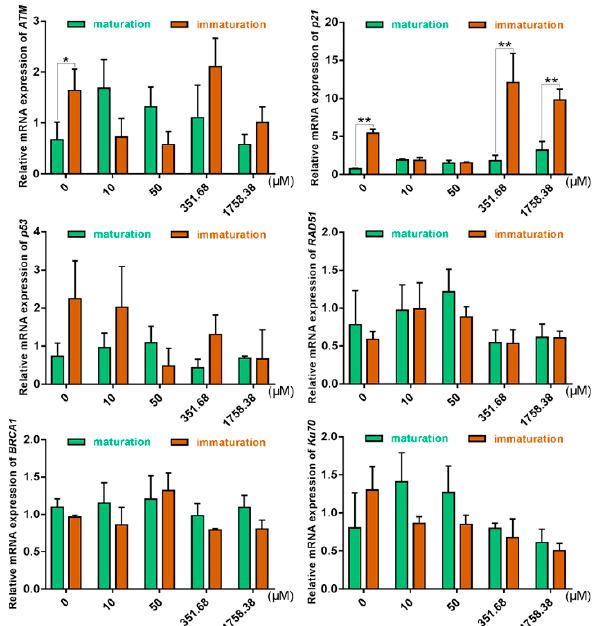
Figure 4. Relative mRNA expression levels of DNA DSBs repair genes in oocytes by qRT-PCR. After bovine COCs were treated with di ff erent concentrations of Zeocin (0 µ M, 10 µ M, 50 µ M, 351.68 µ M or 1758.38 µ M) for 22 h, the oocytes at PBEI (“maturation”, green charts) and oocytes at GV (“immature”, orange charts) were collected to detect DNA DSBs repair genes. * indicates p < 0.05, ** indicates p < 0.01.